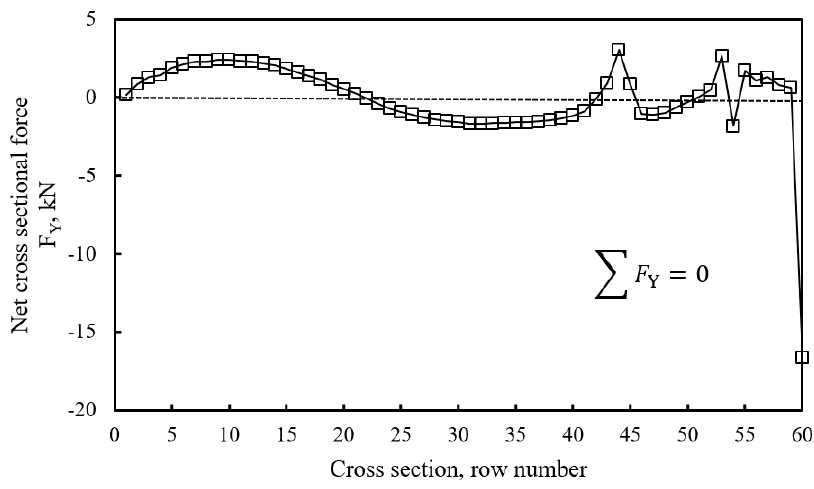
Figure 7. Cross-sectional force equilibrium condition in the Y direction.